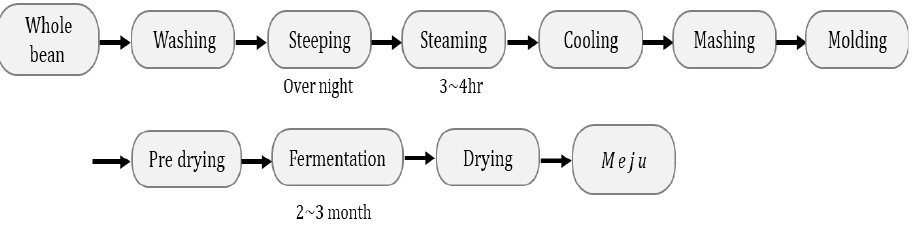
Figure 3. Procedure for the preparation of meju.